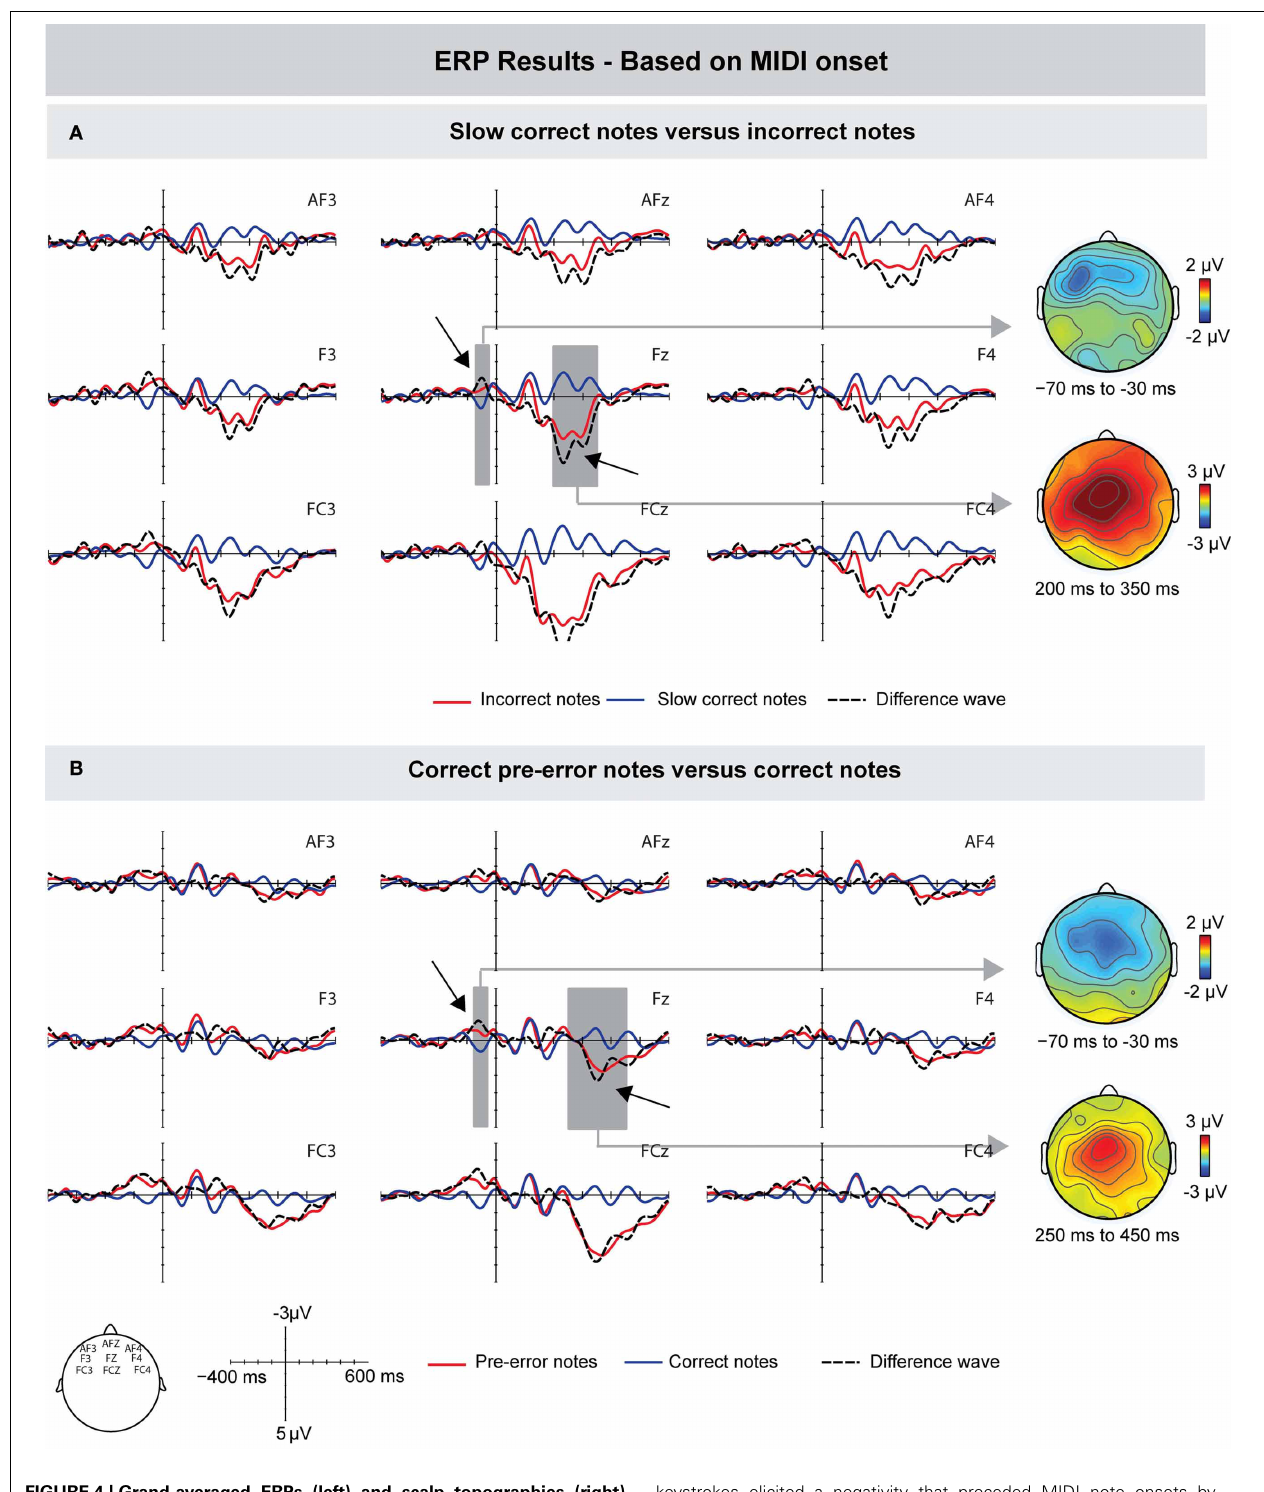
keystrokes elicited a negativity that preceded MIDI note onsets by about 60ms, followed by a positivity peaking around 350ms after MIDI note onsets. Gray areas show the time windows used for statistical analysis, exemplarily on one electrode. On the right side, corresponding scalp topographies are shown as the difference potentials between two conditions in the given time